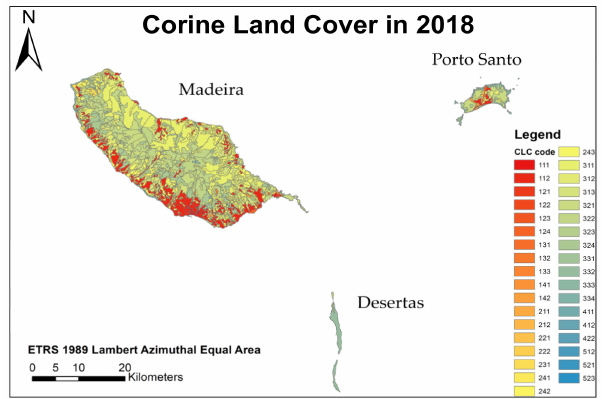
Figure A8. Thematic cartography regarding the land-use changes in the Madeira Archipelago in the year 2018.